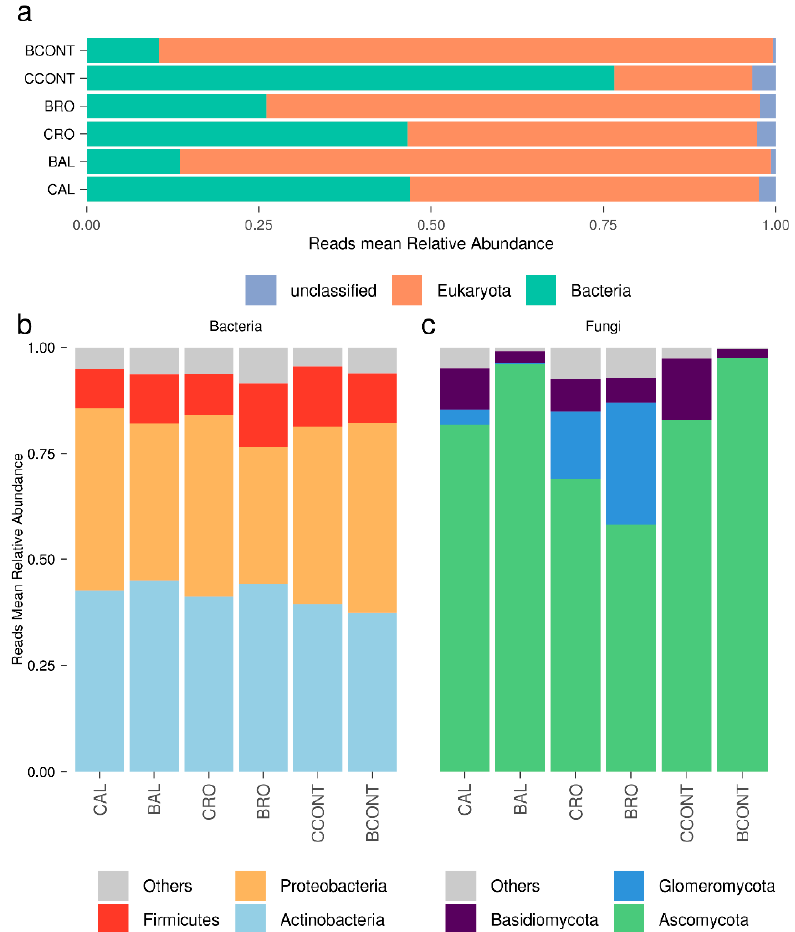
Figure 1. Active taxonomic diversity of root-associated microbiota of tomato plants grown in native and control soils. ( a ) Relative abundance of reads in each condition by superkingdom. ( b , c ) Bar plots of the three most represented phyla for bacteria ( b ) and fungi ( c ) among the di ff erent conditions. The first letter of the sample name indicates genotype (“Cuore di Bue” or “Battito”), while the following part refers to the soil/substrate type (RO, “Rosta” conducive soil; AL, “Albenga” suppressive soil; control (CONT), neutral peat-moss substrate).